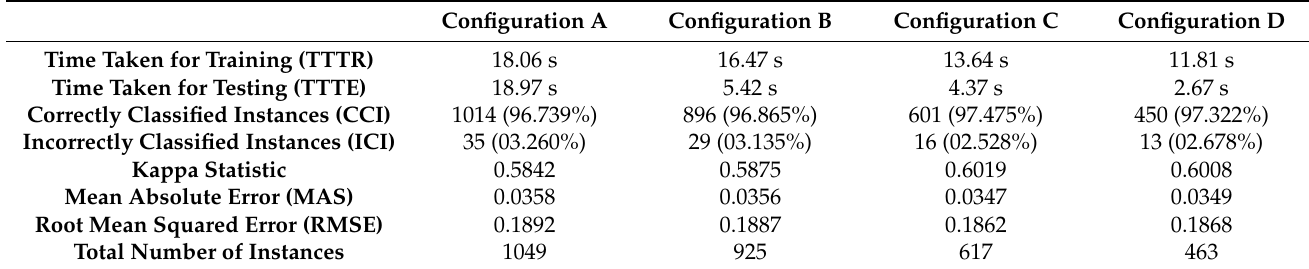
Table 7 represents the evaluation of the split test using the tetrad of feature selection technique in combination with LL, and its graphical representation is shown in Figure 8. Table 7. Evaluation of test split (tetrad feature selection techniques).